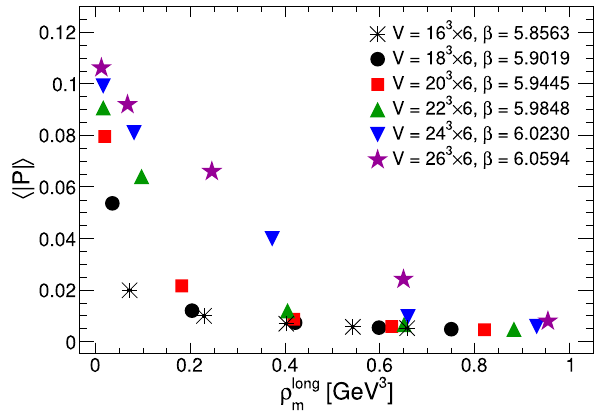
Fig. 4 The relation between the order parameter (cid:5)| P |(cid:6) and the number density of the long monopole loops ρ long m at finite